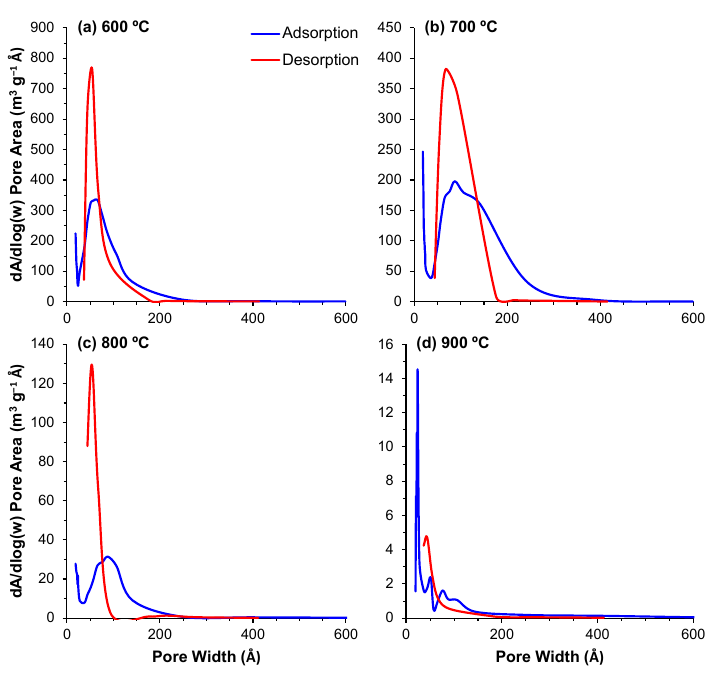
Figure 5. ( a – d ) Contribution of the different pore sizes to the overall surface area for the powders calcined at temperatures of 600–900 °C.